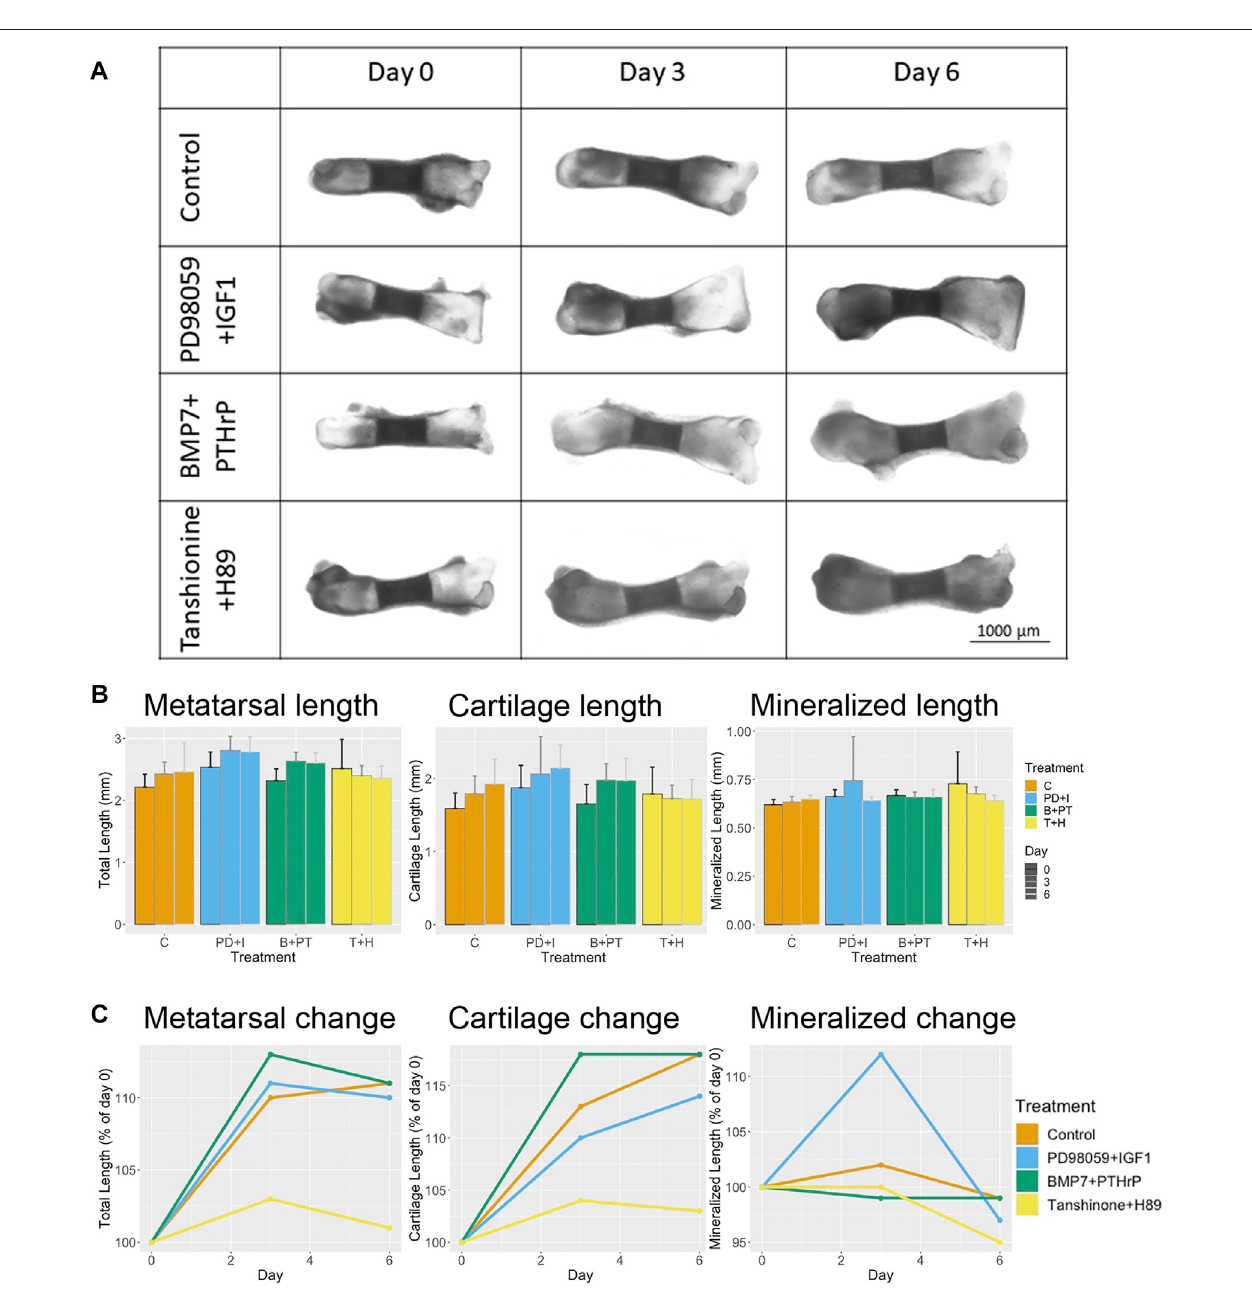
FIGURE 6 | Treatment with a combination of PD98059 (ERK1/2 inhibitor) +IGF1 or a combination of BMP7+PTHrP slightly increases longitudinal length with time, whereas the combination of Tanshinone (DLX5 activator) and H89 (PKA inhibition) decreases longitudinal length as compared to control. (A) Morphological changes of representativeratpupmetatarsalscausedbyPD98059(ERKinhibitor)+IGF1,BMP7+PTHrPandTanshinoneIIA(DLX5activator)+H89(PKAinhibitor)atday0,3and6. (B) Change in metatarsal longitudinal length, cartilage length and mineralized bone area length at day 0, 3 and 6 of control and treated samples (C) . Percentage change in metatarsal length, cartilage length and mineralized bone length as compared to control. Data represent the mean of at least 6 metatarsals for each condition.